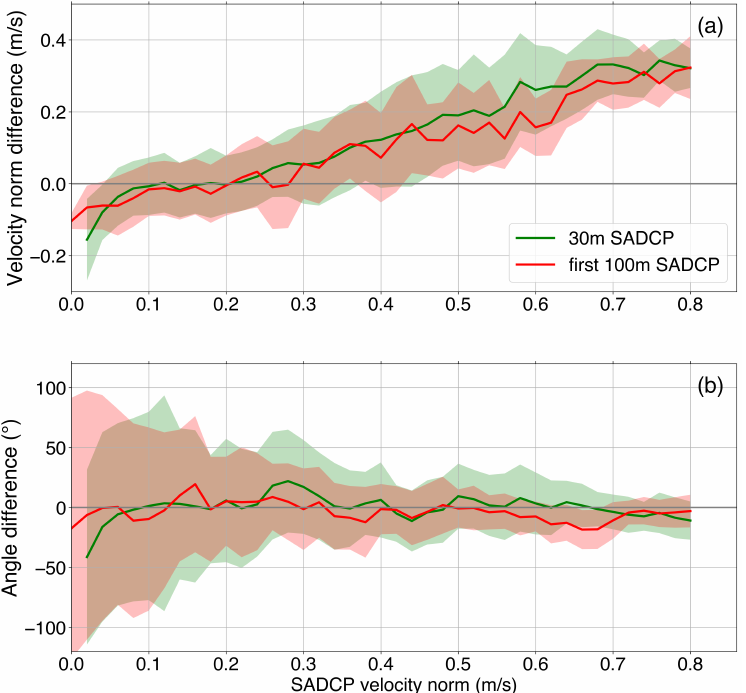
Figure 8. Comparison between S-ADCP and surface geostrophic velocities, derived from satellite altimetry, using all the R/V L’Atalante and R/V Maria S Merian sections with S-ADCP data available until at least 500 m. S-ADCP velocities averaged over the first 100 m are represented in red while S-ADCP velocities at 30 m depth are shown in green. ( a ) Velocity norm difference (m/s) between S- ADCP and surface geostrophic velocities as a function of S-ADCP velocity norm. ( b ) Angle difference (°) between S-ADCP and surface geostrophic velocity vectors as a function of S-ADCP velocity norm. On average, the difference lies between − 25° and 25°, with a larger variability for smaller values of in-situ